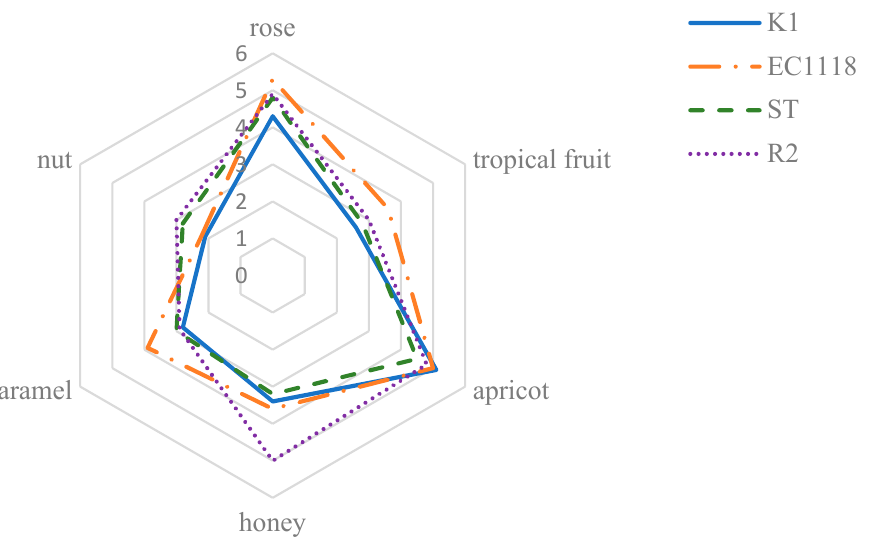
Figure 1. Sensory profiles of Vidal icewines fermented by different yeasts.